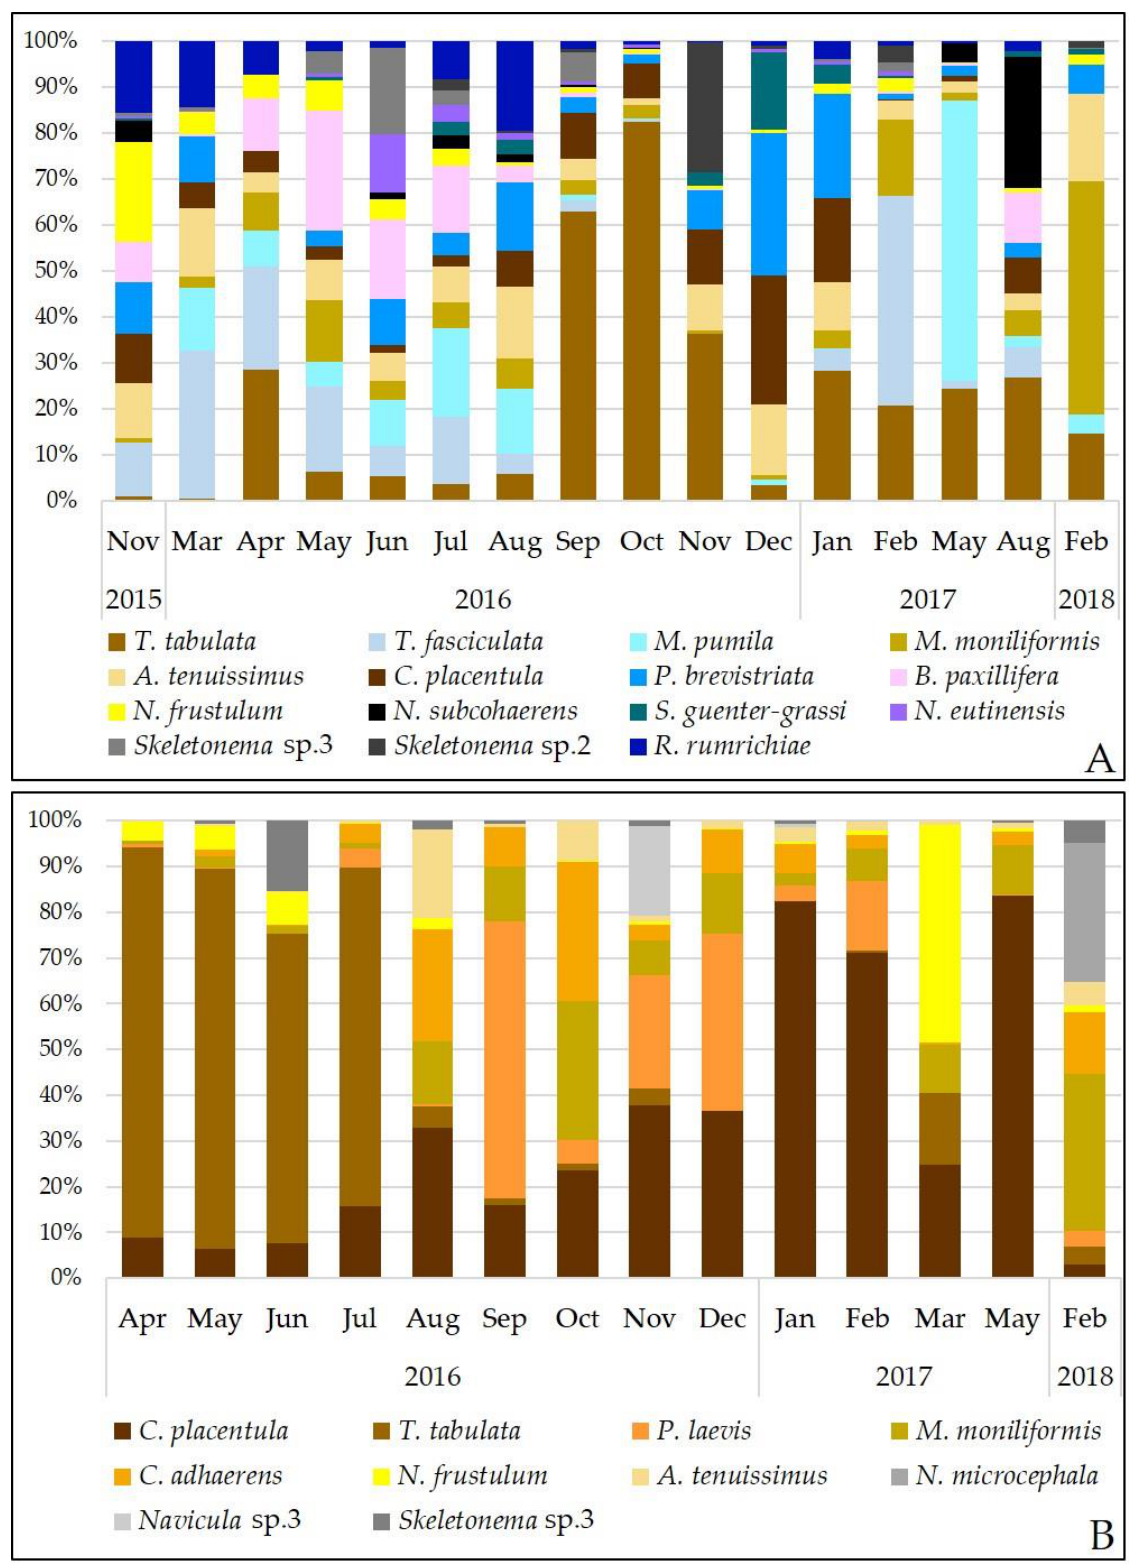
Figure 5. Distribution and proportions of the relative abundance (%) of epiphytic diatoms abundant in the non-impacted site ( A ) and impacted site ( B ). Data for diatoms that presented more than 10% abundance in at least one period.